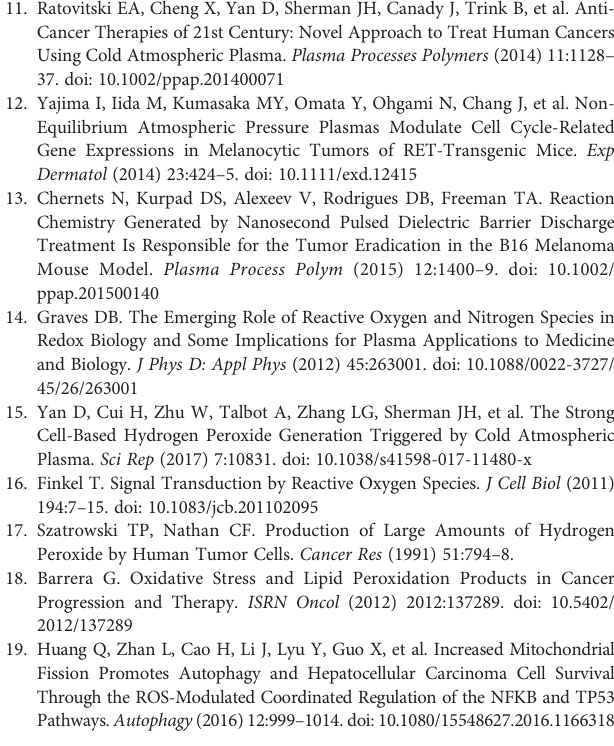
Supplementary Figure 1 | ROS scavenger NAC partly inhibits DBD-CAP- mediated effects on breast cancer cell viability. Morphology of (A) MCF-7, (B) MDA- MB-231, (C) Hs578T breast cancer cells after mild (0.5 kHz/27.6 kV) DBD-CAP (direct, indirect, media change) for 4 min in the absence or presence of NAC